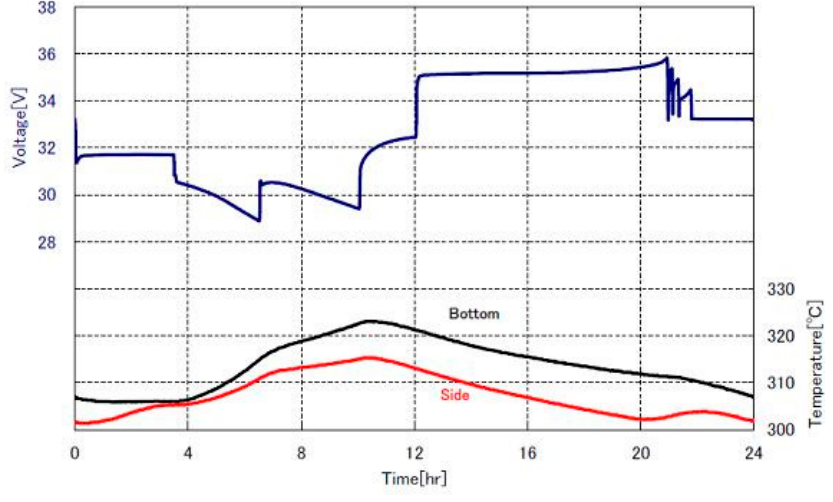
Figure 9. Voltage and temperature (at side and bottom of the module) during a standard cycle.